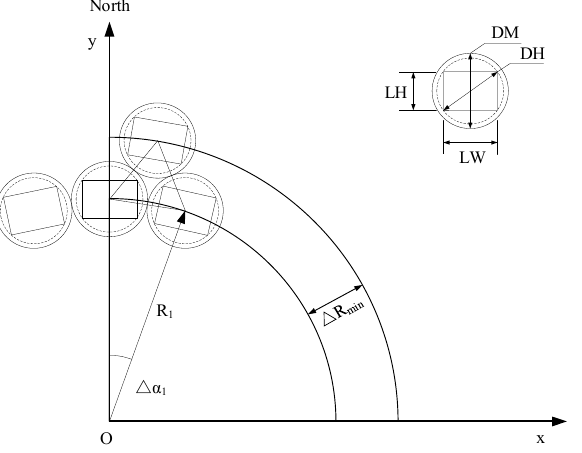
Figure 1. Fundamental definitions in the heliostat field.